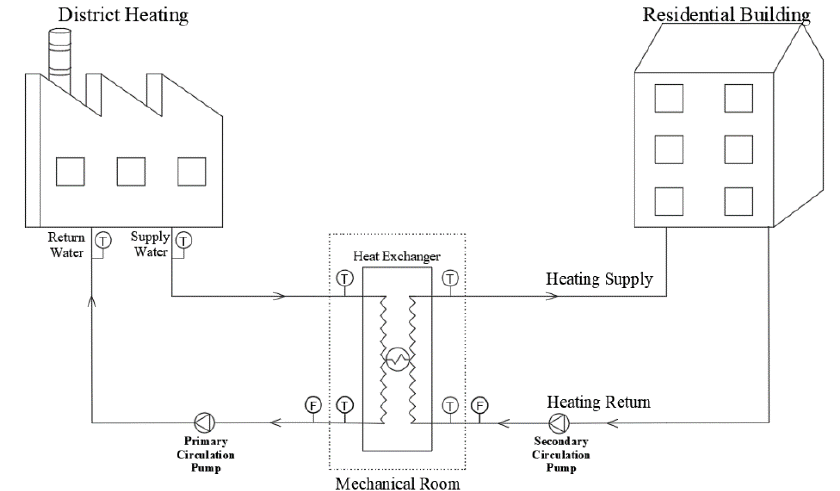
Figure 5. Conceptual diagram of the district heating system.